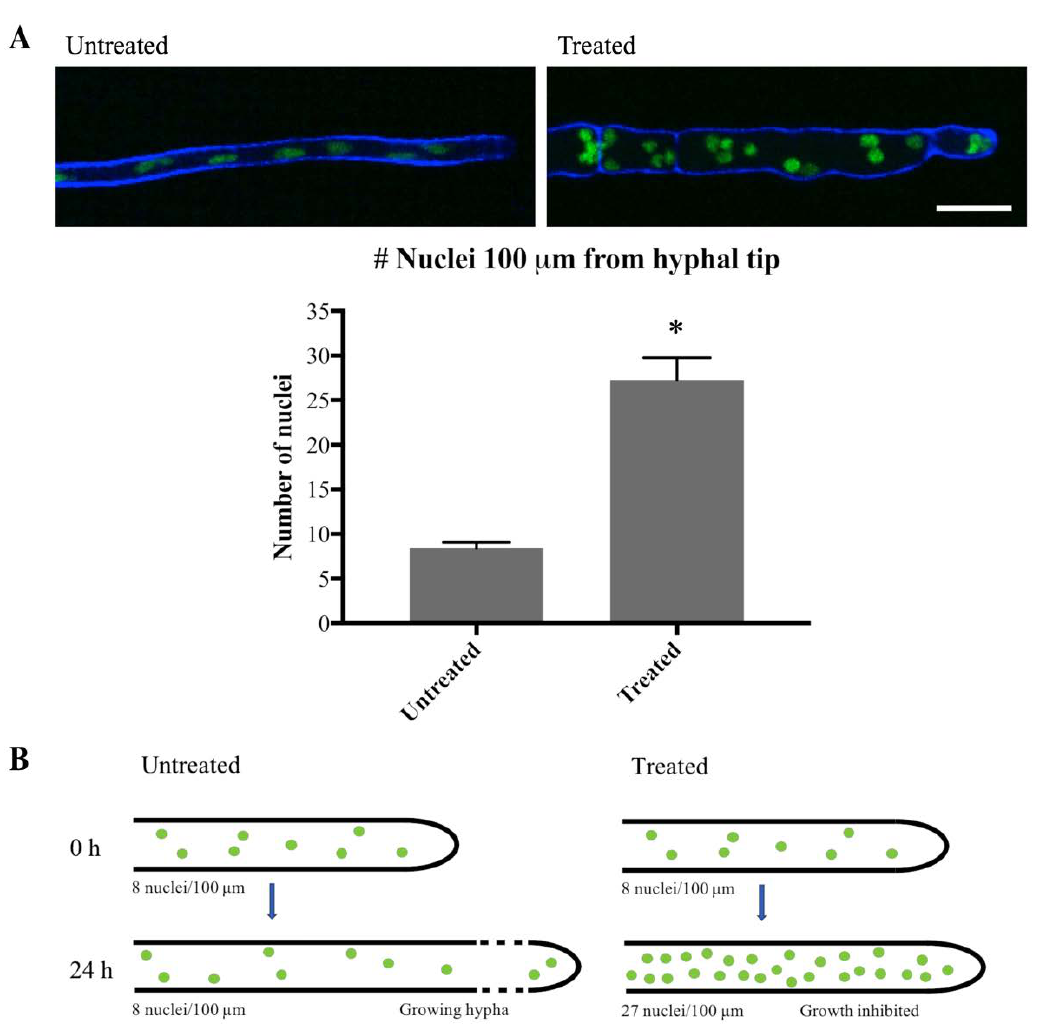
Figure 7. Olorofim treatment inhibits mitosis. ( A ) Imaging of H1-GFP nuclei within 100 µm of the hyphal tip at 0 h (Untreated) and 24 h (Treated) following addition of olorofim. Scale bar = 10 µm. Error bars represent SD. ( B ) After 24 h of olorofim treatment, only 1–2 rounds of mitosis are estimated to take place, based on the accumulated number of nuclei in the hyphal tip. In untreated hyphae, newly formed nuclei move along with the growing hyphal tip, resulting in more equally dispersed nuclei. * p < 0.01.